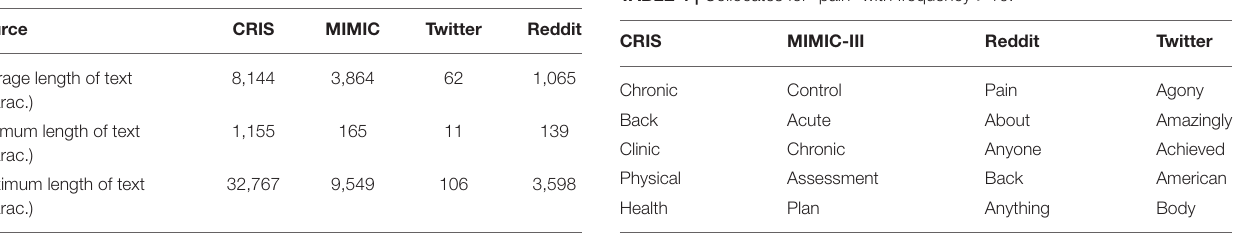
TABLE 3 | Common themes around “pain” in the 50 randomly selected documents from the four data sources. Source Quality/Type of